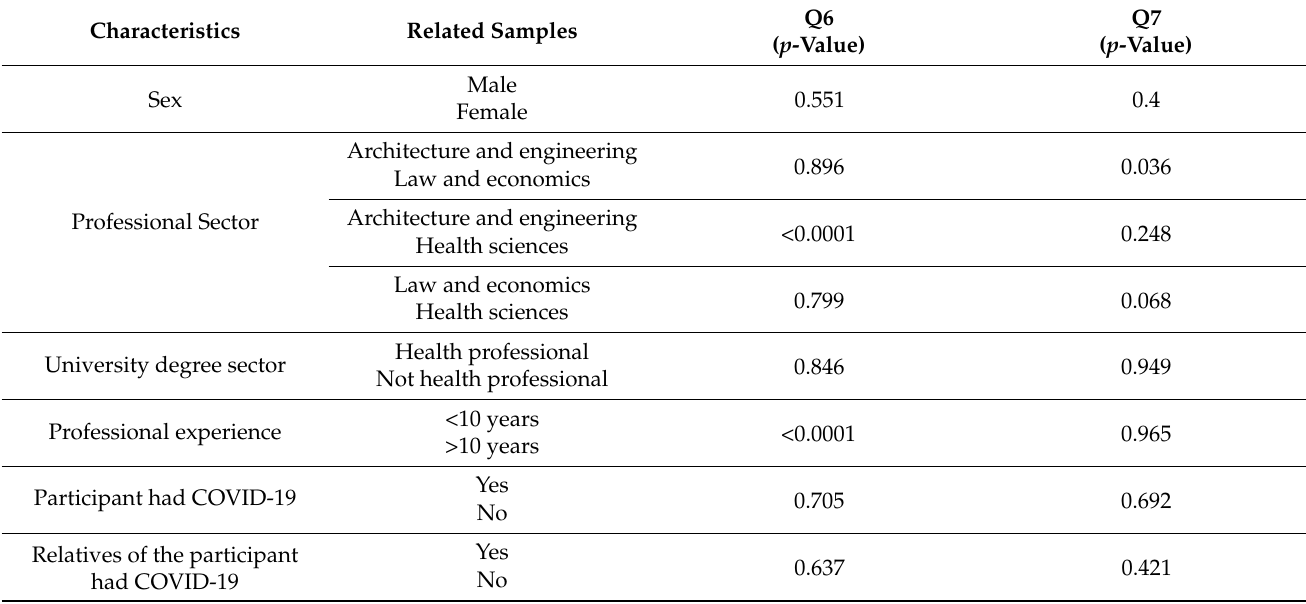
Table 6. Statistical significance analysis about technological development and robotics.